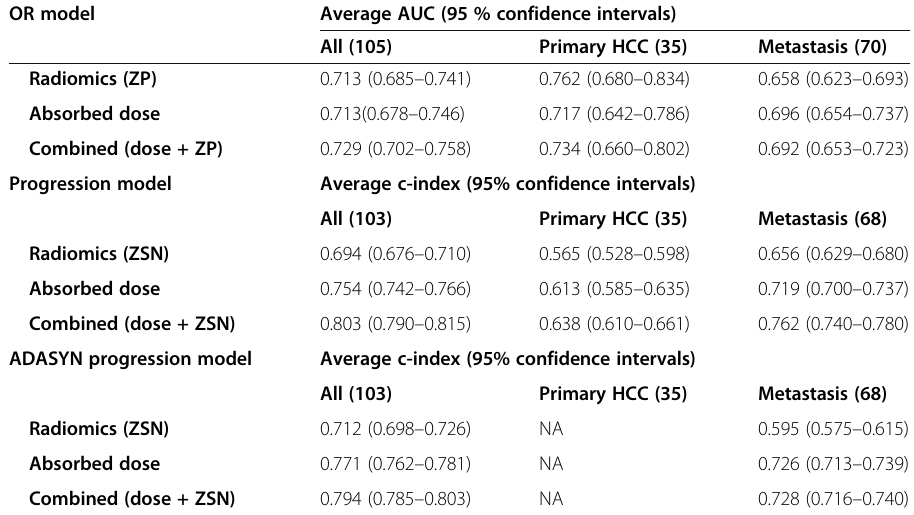
Table 3 Average AUC/c-index for individual and combined models with all the lesions, HCC lesions, and metastasis lesions OR